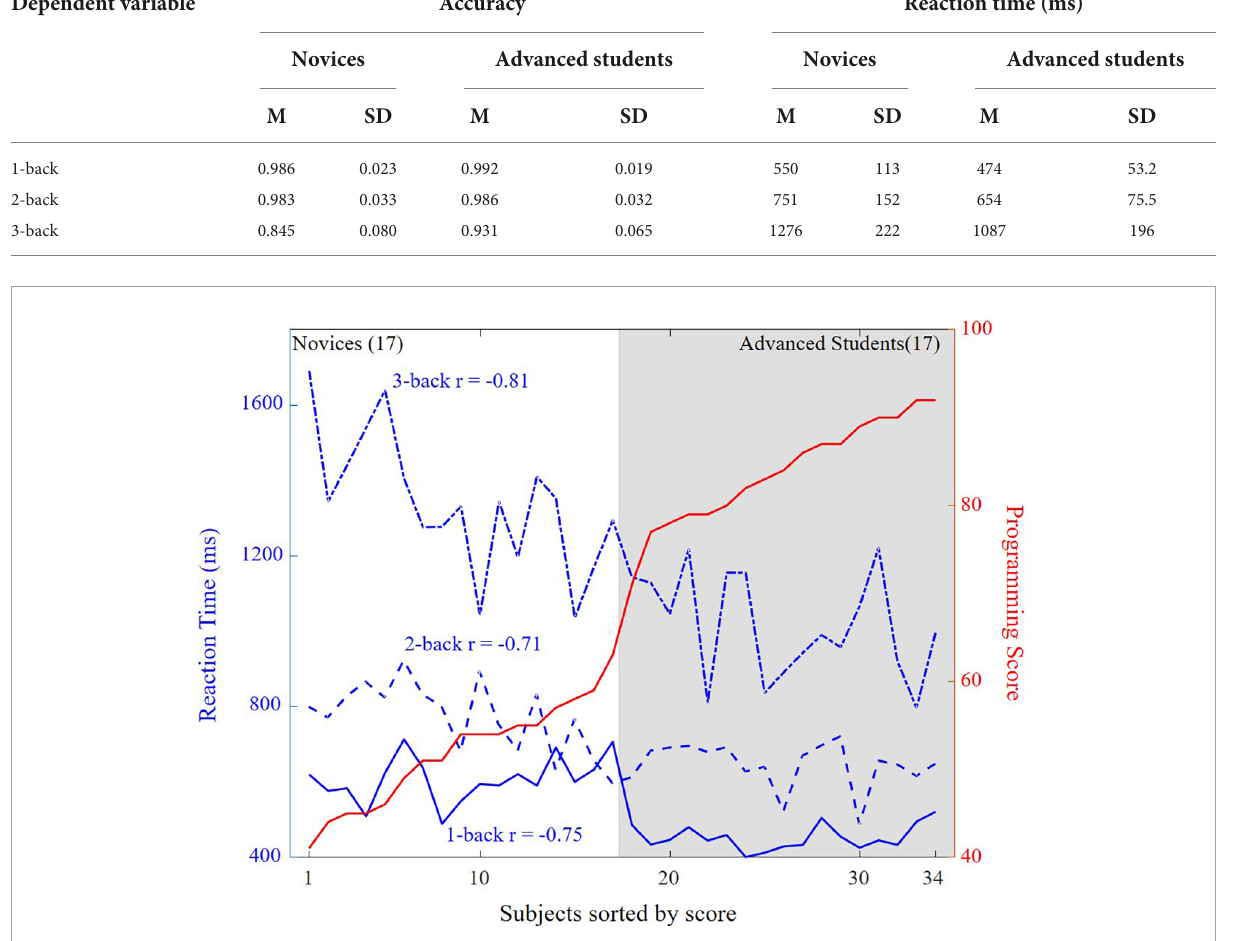
FIGURE5 Correlations between reaction time and programming score for the three n-back levels.